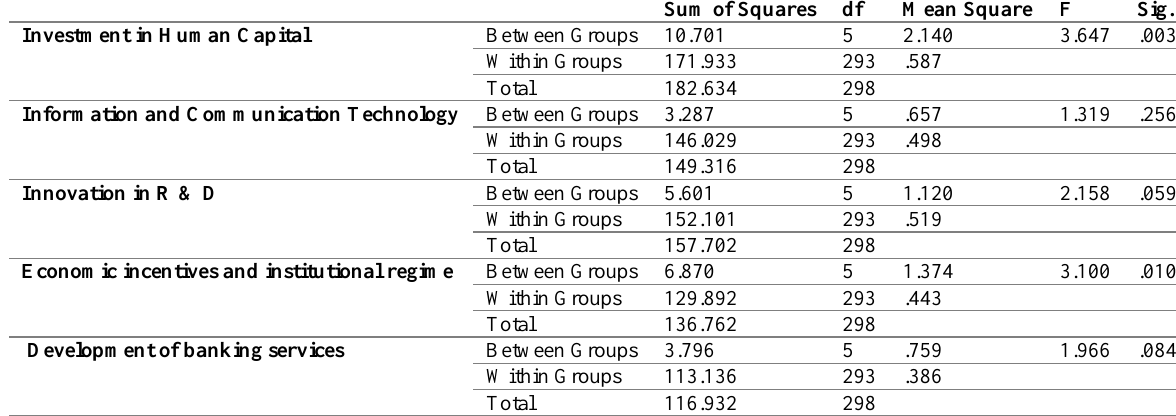
Sum of Squares df Mean Square